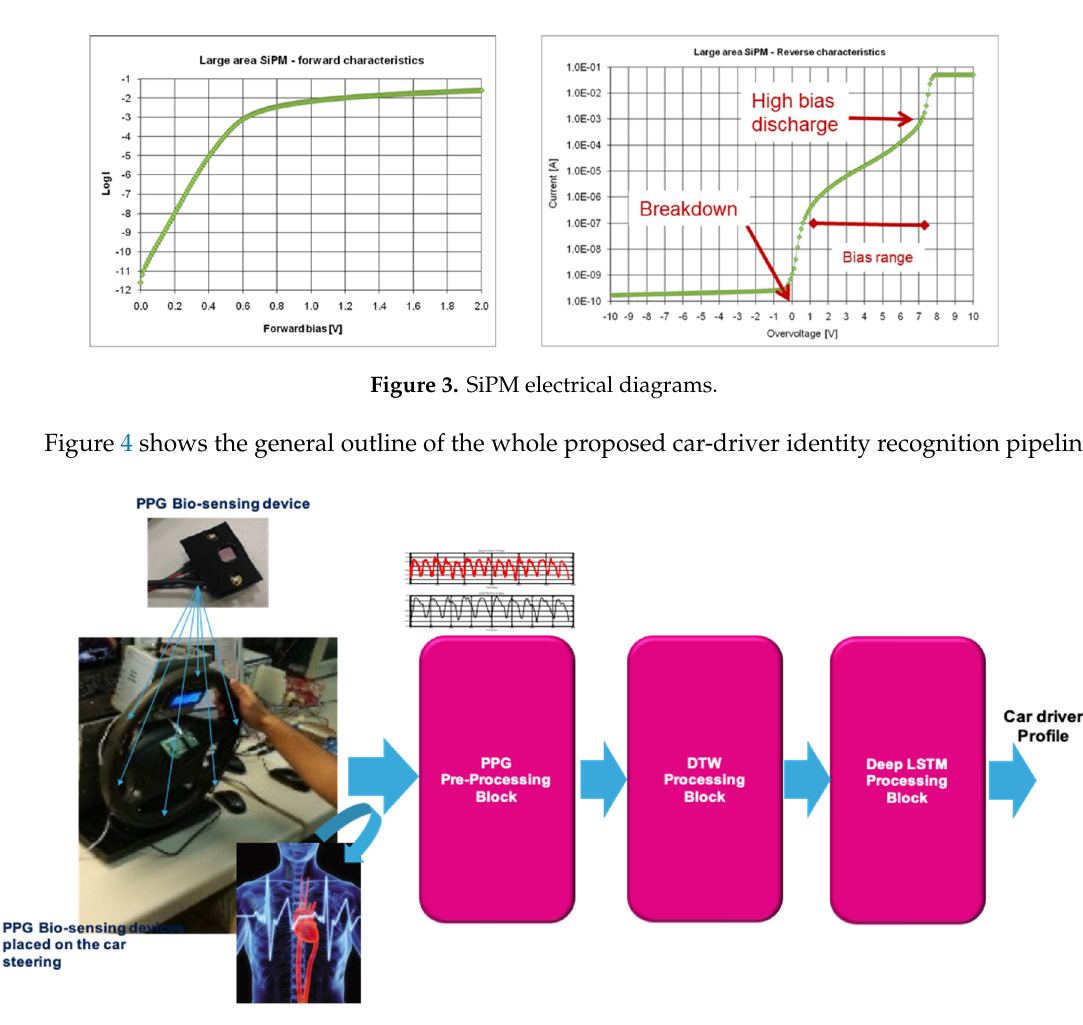
Figure 4. The overall scheme of the proposed car-driver identity recognition pipeline.